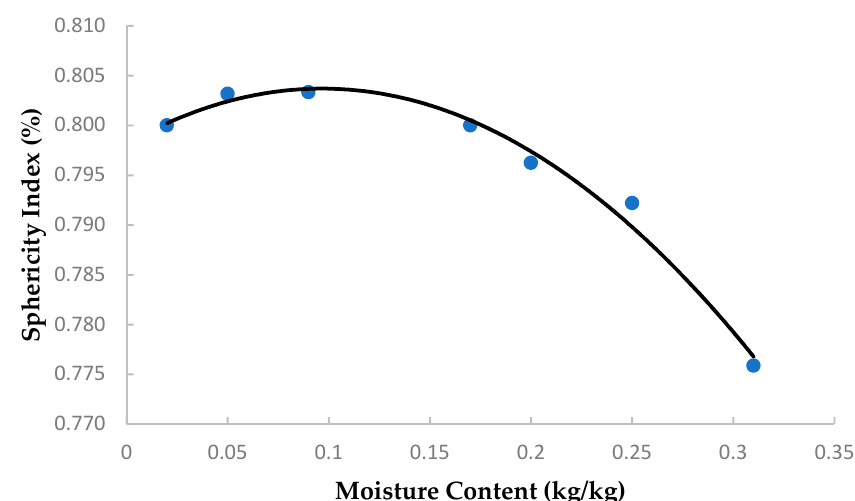
Figure 2. Sphericity index ( γ ) of palm kernel at different moisture contents.